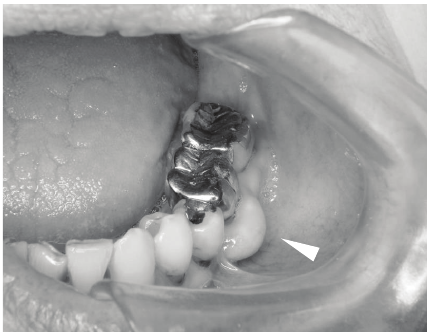
Figure 2: Obvious swelling of the buccal alveolar bone at the left mandibular first molar was observed. No other bone swelling was